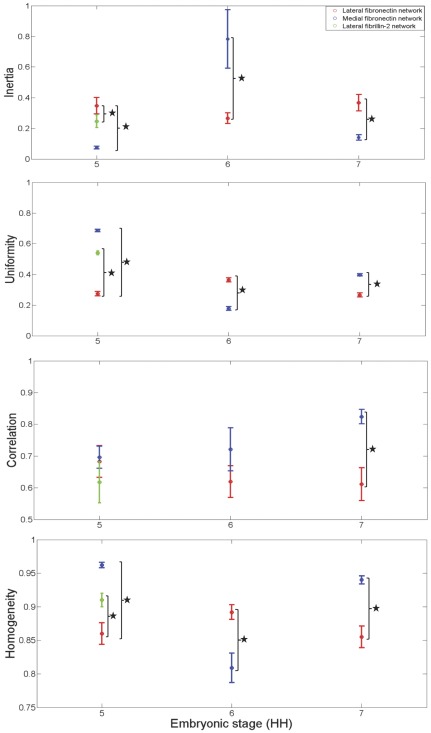
Texture measures at each embryonic stage (HH5 through HH7), averaged over orientation and spatial scale.The overall trend (spatial anisotropy and temporal fluctuations) in the textural measures during stages 5 through 7 was evident upon averaging the Haralick feature values (from figures 2 through

5) over orientation (0°, 45°, 90° and135°) and scale (offsets 1 through 4 corresponding to each orientation). Values are mean ± S.D. Fibrillin-2 lateral network at stage 5 is shown in green, while lateral and medial fibronectin networks are shown in red and blue, respectively. Statistically significant differences (P<0.05) between ROIs were represented by “ * ”.